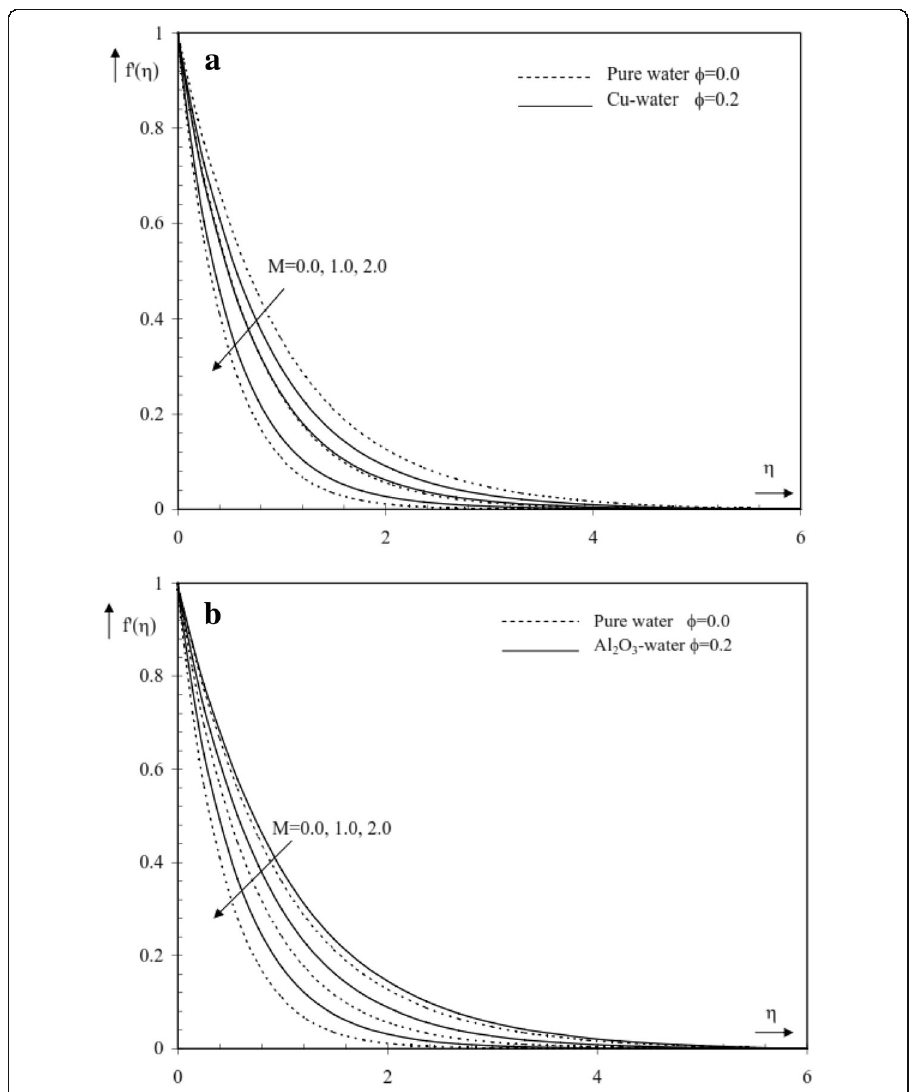
Fig. 5 Effects of ϕ and M on velocity distribution f ′ ( η ) for S = 0.1, f w = 0.1, and A = B = λ = 0.5 for a Cu-water and b Al 2 O 3